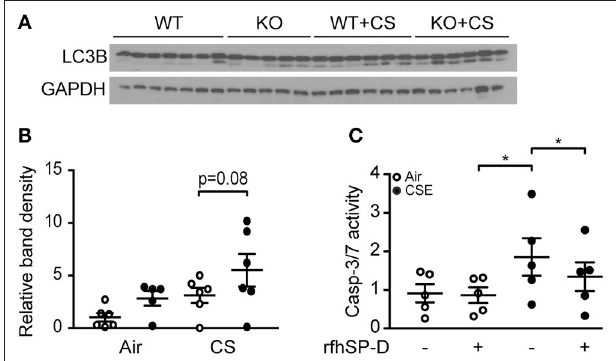
FIGURE 8 | The effect of endogenous and exogenous SP-D on cigarette smoke (CS)-induced human epithelial cell death. (A,B) Autophagy marker LC3B-II (lower band) is increased in lung homogenates of SP-D-deficient mice after 12 weeks of CS exposure. Each lane in (A) represents a single lung homogenate sample, and the relative band density is quantified in (B) . (C) In vitro administration of recombinant fragment of human SP-D (rfhSP-D) attenuates cigarette smoke extract (CSE)-induced apoptosis of A549 alveolar epithelial cells. The cells were pre-treated with 20 µ g/ml rfhSP-D for 1h before stimulation with 2.5% CSE for 24h. Apoptosis was measured as relative caspase-3/7 activity. Data are means of 5 independent experiments. * p < 0.05, analyzed by one-way ANOVA followed by Bonferroni’s